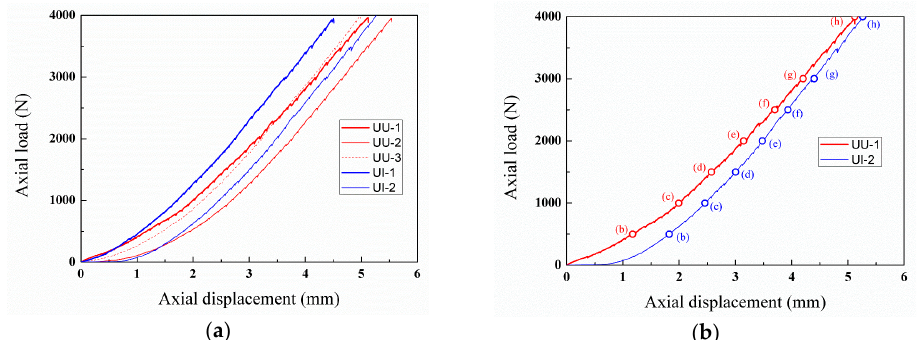
Figure 6. Load–displacement curves for UU and UI subjected to uniaxial loading: ( a ) overall data; ( b ) selected data for comparison.